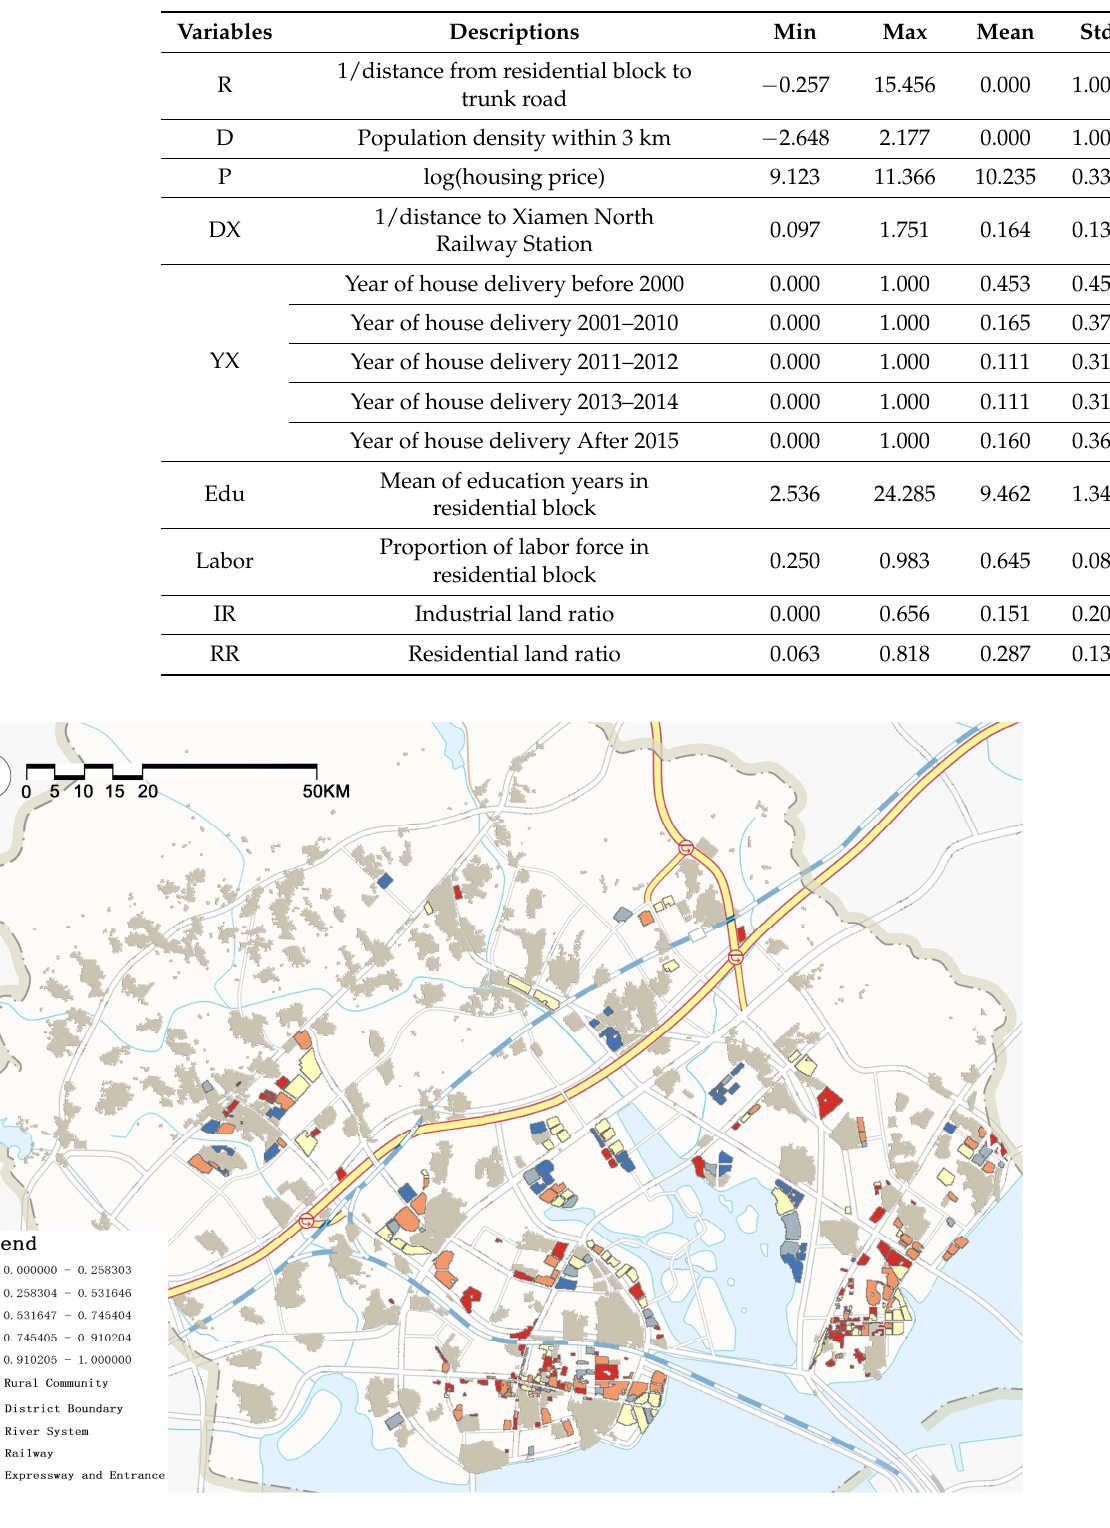
Figure 2. Spatial distribution of occupancy rate.